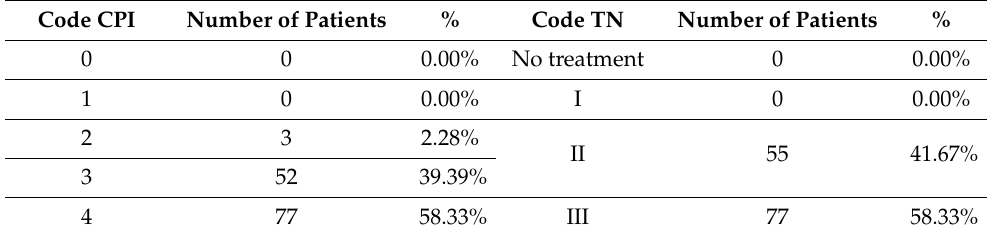
Table 5. Periodontal status of the study population as assessed by the CPITN index.